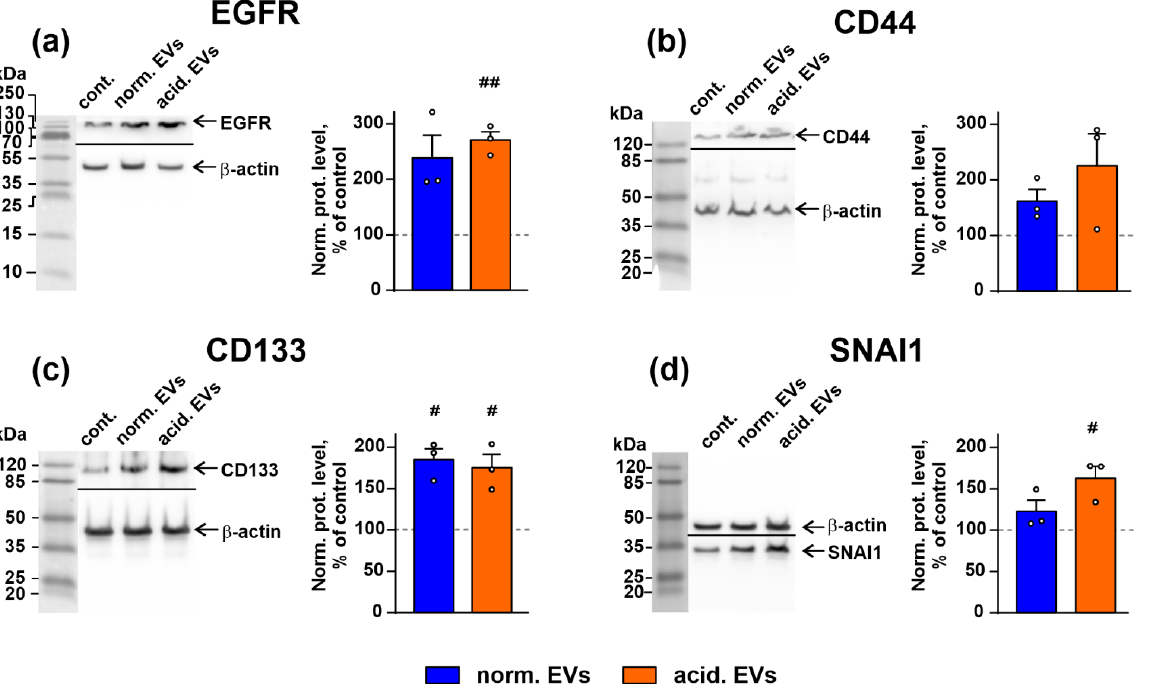
Figure 4. Influence of “normal” and “acidified” EVs on the expression of EGFR ( a ), CD44 ( b ), CD133 ( c ), and SNAI1 ( d ) in the keratinocytes. Representative Western blot images of EGFR, CD133, CD44, and SNAI1 stained by the specific antibodies in the keratinocytes and the normalized expression levels of the corresponding proteins are shown on the left and right panels, respectively. Data presented as the ratio of the expression level of the target protein to the level of β -actin, normalized to the untreated cells ± SEM ( n = 3). # ( p < 0.05) and ## ( p < 0.01) indicate significant differences between the treated and untreated cells (control, shown by dashed lines) according to the one-sample t-test. Whole Western blotting membranes are presented in Figure S13.